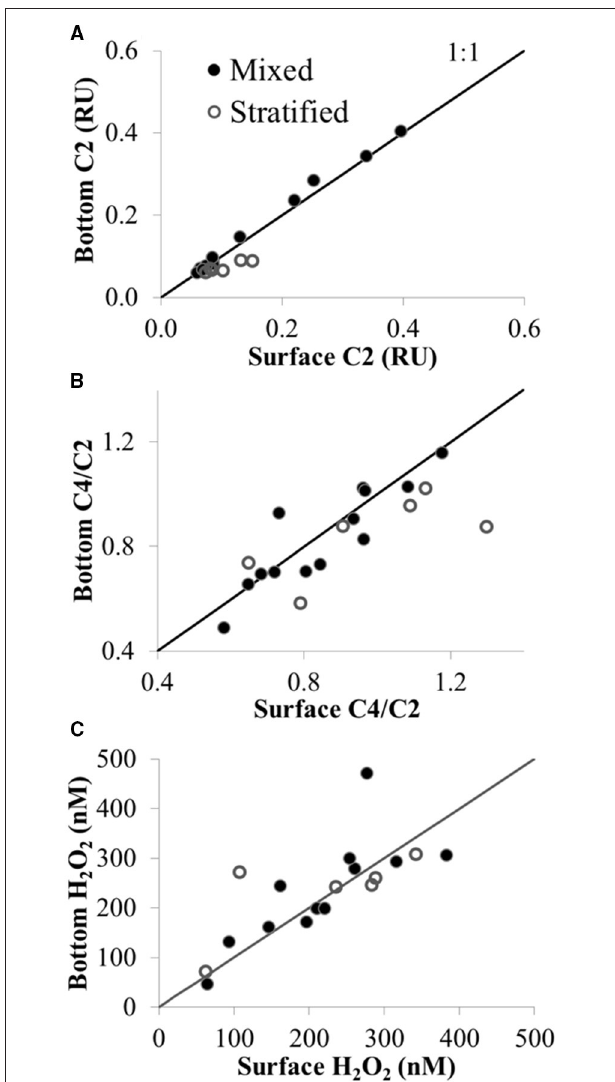
FIGURE 8 | CDOM fluorescence and H 2 O 2 in surface (upper 1 m) vs. bottom waters (4–61m) under mixed and stratified conditions in Lake Erie plotted with the 1:1 line. (A) Concentration of CDOM component C2 (terrestrial humic-like FDOM) in Raman Units (RU). (B) Ratio of amino acid to terrestrial CDOM (C4/C2). (C) H 2 O 2 concentration (nM). Sites sampled with depths > 7m were those sampled in the central and eastern basin of Lake Erie on the Limnos cruises (see Figure 1 ).